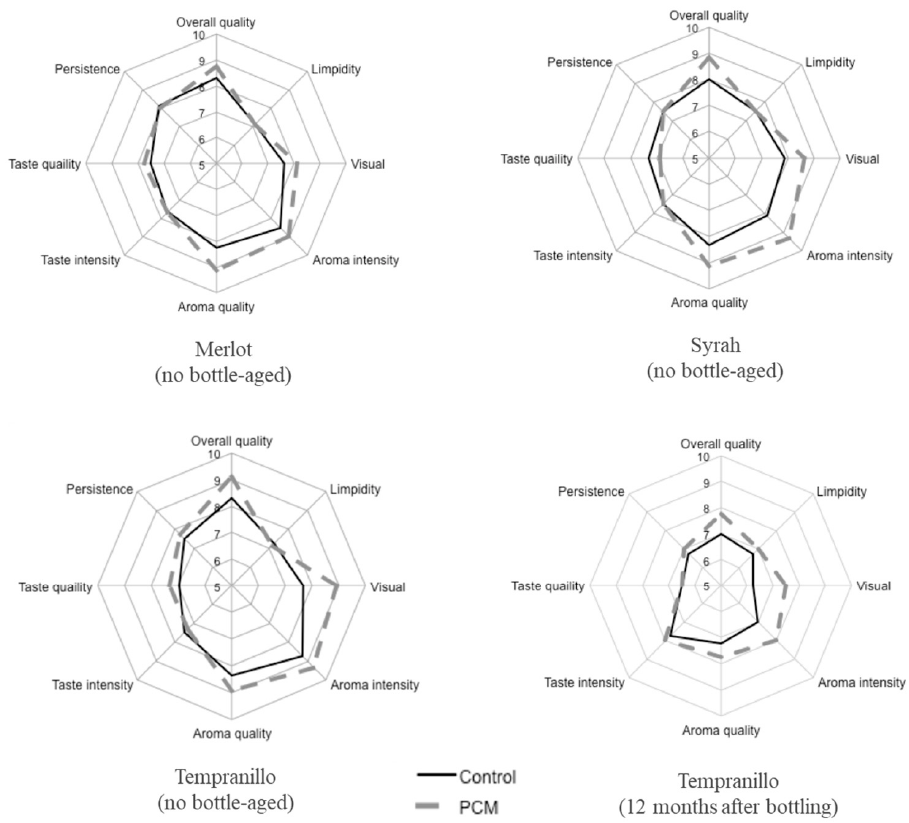
Figure 6. Sensory analysis of control and PCM bottled wines of the three studied varieties, and after 12 months of bottle aging (only in Tempranillo variety).